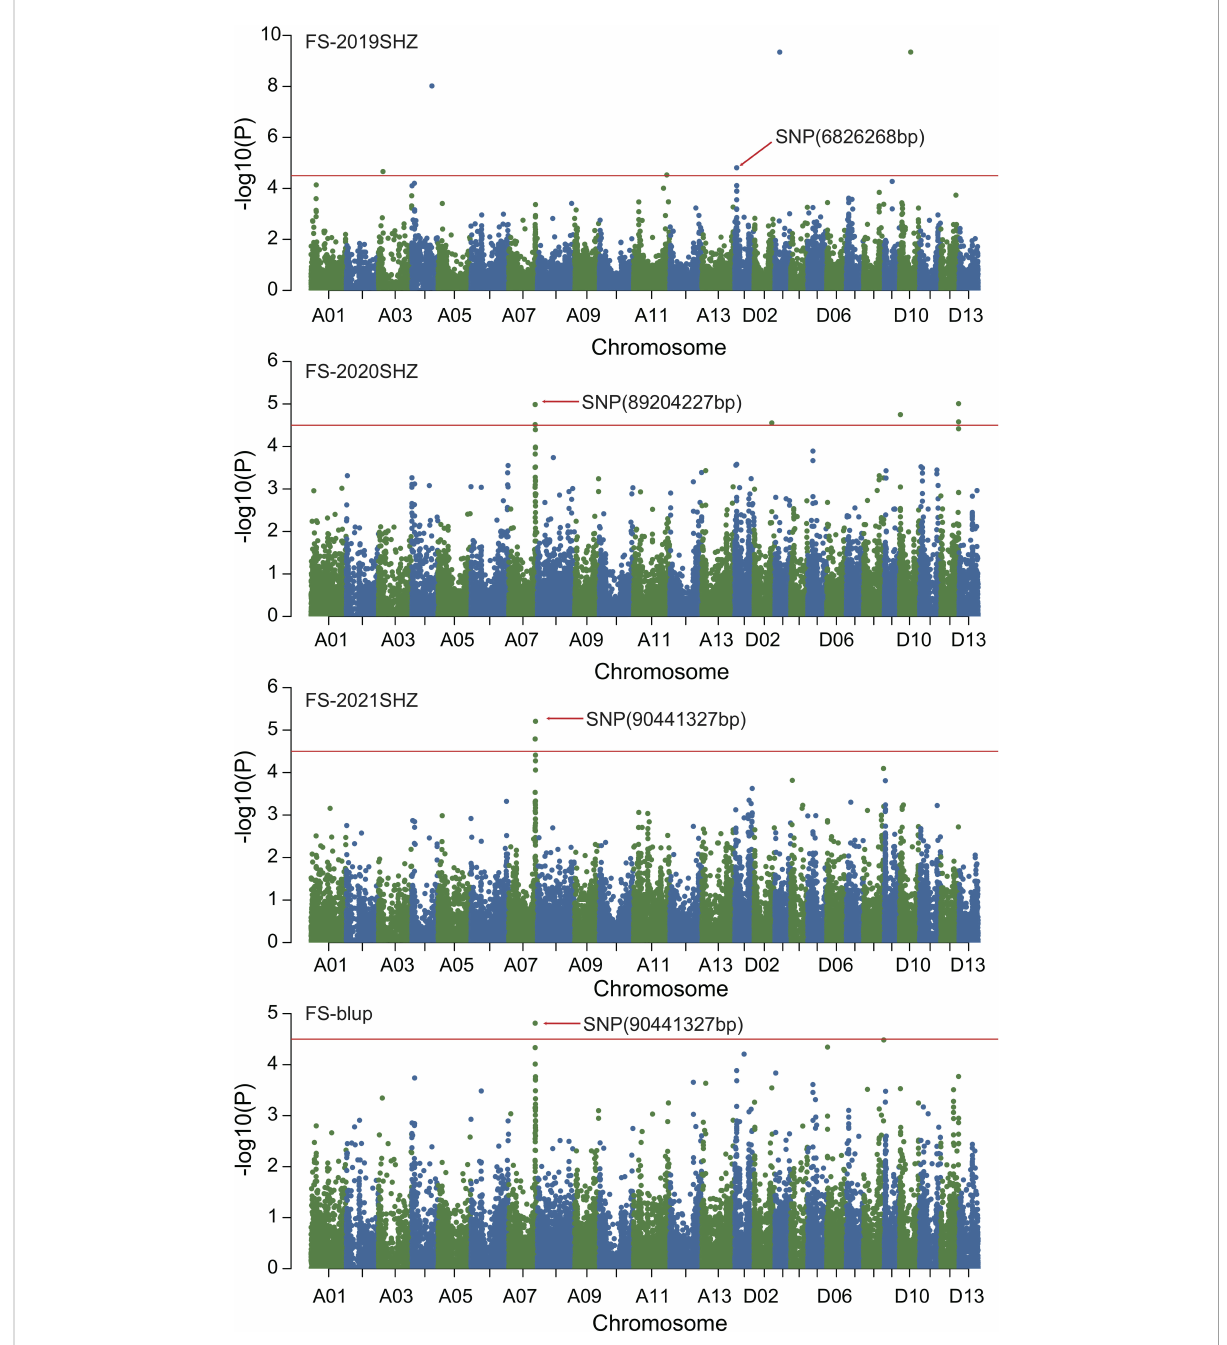
FIGURE 4 Manhattan of genome-wide association studies for fi ber strength. FS-2019SHZ: Fiber strength in the Shihezi environment 2019; FS-2020SHZ: Fiber strength in the Shihezi environment 2020; FS-2021SHZ: Fiber strength in the Shihezi environment in 2021; FS-blup: Fiber strength in the blup